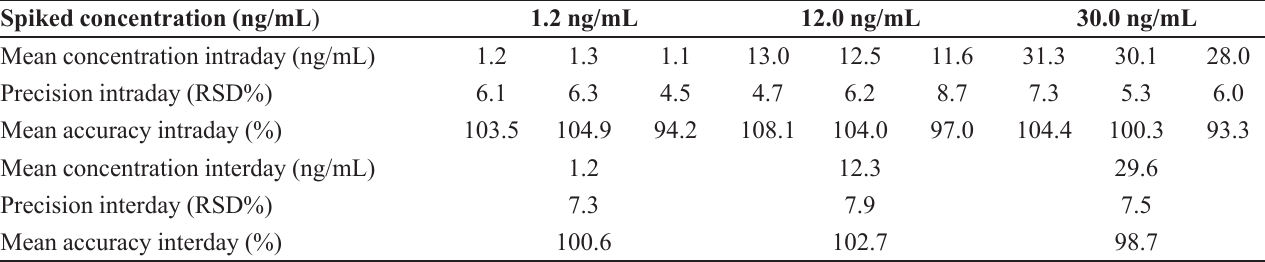
TABLE I - Precision and accuracy for simvastatin in human plasma Spiked concentration (ng/mL )